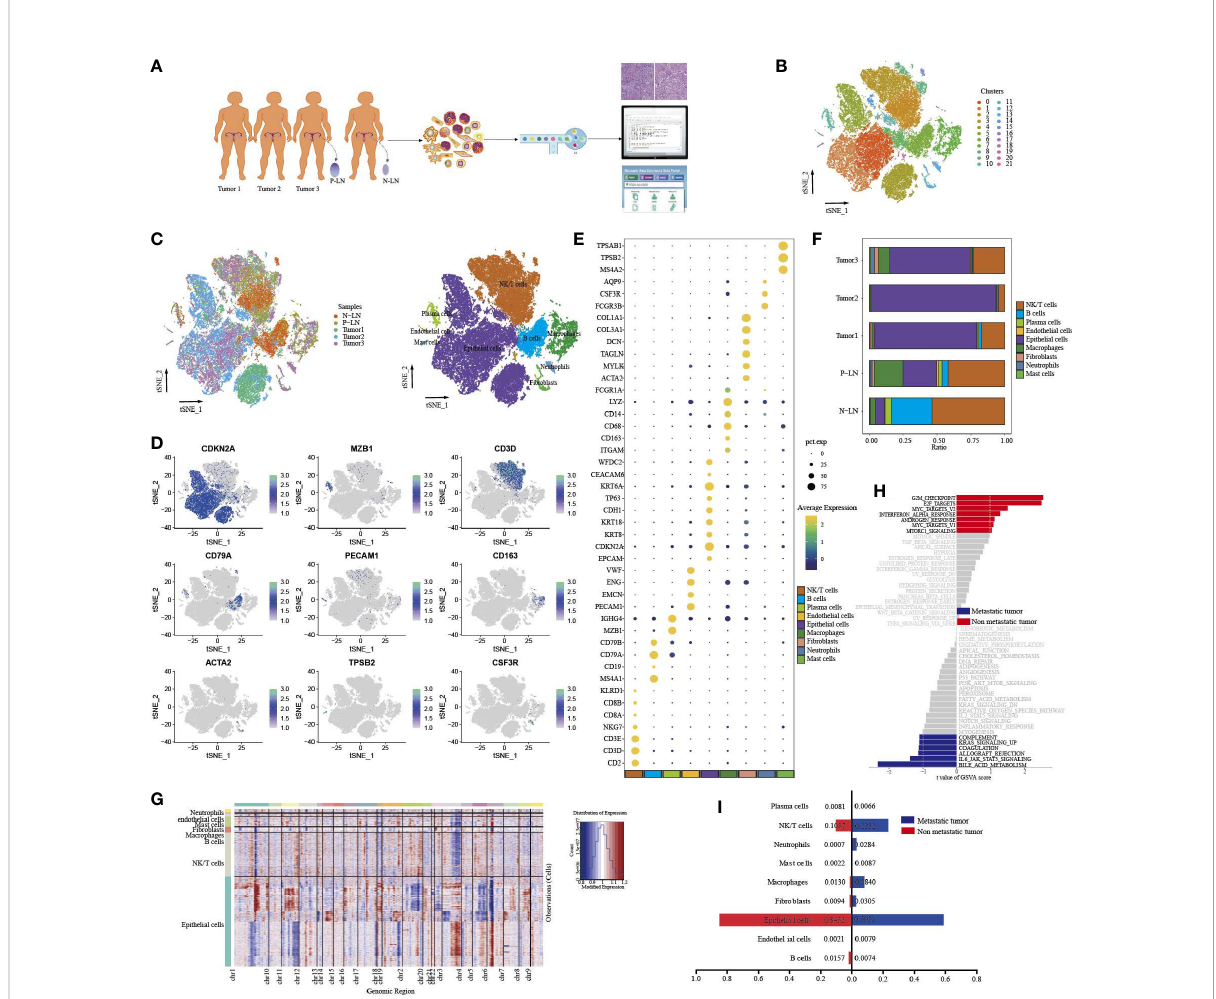
FIGURE 1 Single-cell transcriptome pro fi les of CC primary tumor and metastatic lymph node. Work fl ow depicting the collection and processing of samples for scRNA-seq analysis (A) . tSNE of all cells pro fi led here, with each cell color-coded for clusters (B) . tSNE of all cells pro fi led here, with each cell color-coded for (left to right) the corresponding samples and the cell types (C) . tSNE of representative genes for each cell type (D) . Dot plot of signi fi cant marker genes for each cell type (E) . The proportion of each cell type in fi ve samples (F) . Heatmap showing large-scale CNVs of each cell type (G) . GSVA of hallmark gene sets between metastatic tumor (tumor 3) and non-metastatic tumors (tumors 1 and 2) (H) . The difference in cell type proportion between metastatic tumors (tumor 3) and non-metastatic tumors (tumors 1 and 2) (I)